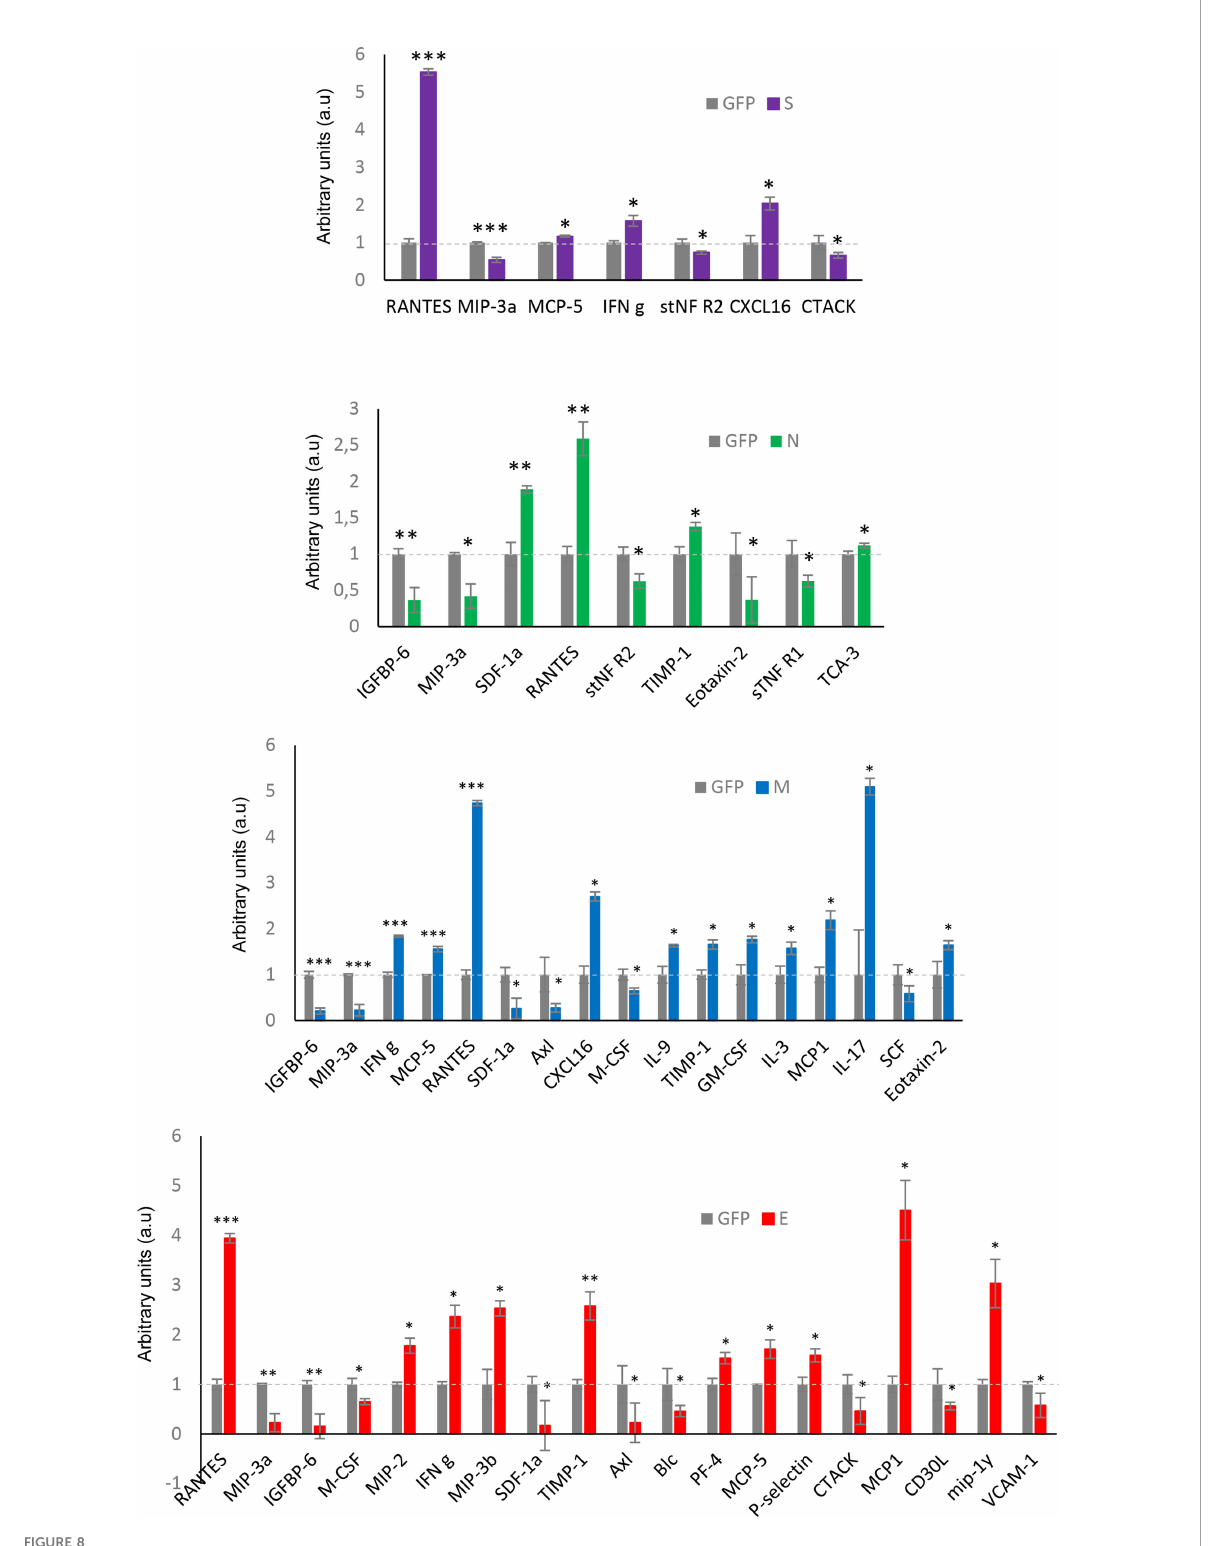
FIGURE 8 Extracellular cytokine pro fi ling of GFP- SARS-CoV-2 structural protein-expressing OBC1 cells. The analysis of 62 cytokines/growth factors was performed in the cell media derived from all biological conditions using a dot-blot protein array method. Four independent experiments were performed. Data are presented as mean ± SEM. *p < 0.05, **p < 0.01, and ***p < 0.001 vs